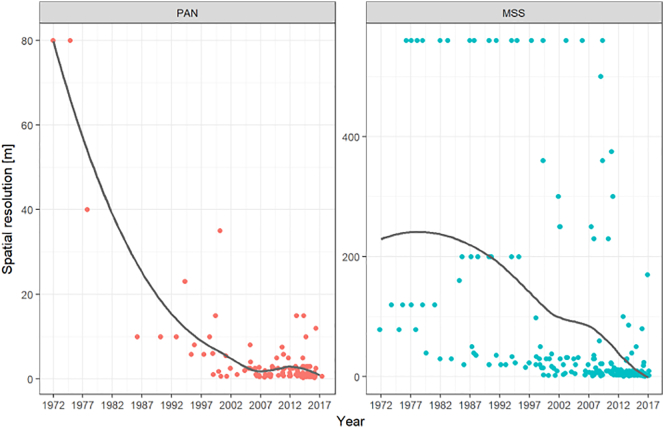
The increase of spatial resolution of panchromatic and multispectral sensors through the years. Dots represent an existing satellite and its highest available resolution, and the line represents the moving average. The higher the resolution (i.e. the smaller the size of the pixel), the more information can be extracted from the image.